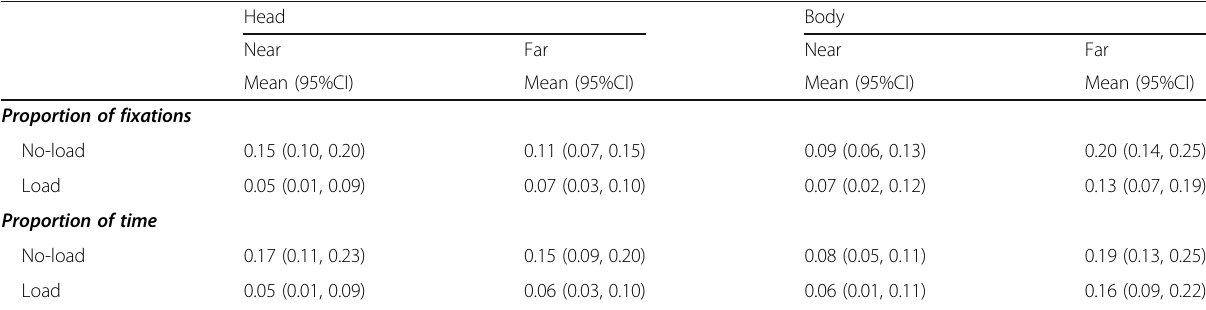
Table 3 Proportion of fixations toward the head and body by Condition (no-load, load) and Proximity (near, far) in Experiment 1